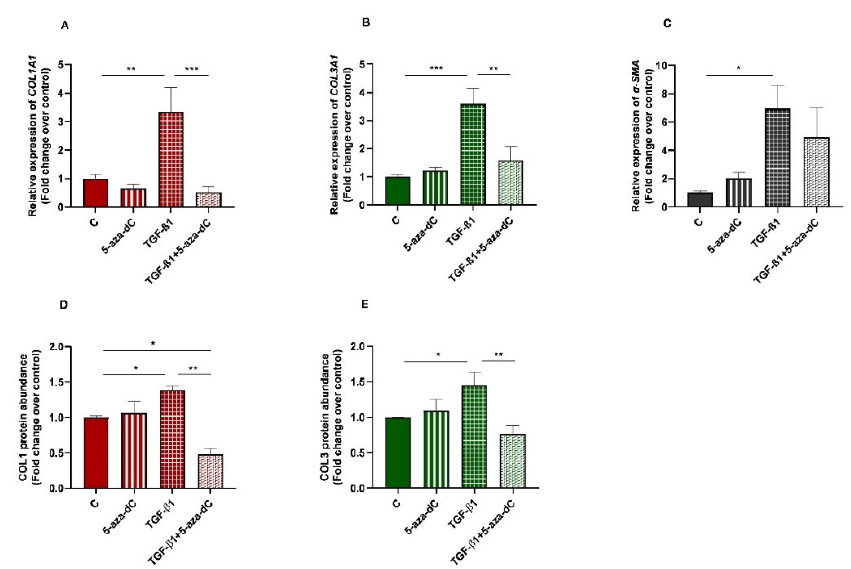
Figure 4. Relative levels of ( A ) collagen type I ( COL1A1 ), ( B ) collagen type III ( COL3A1 ), and ( C ) α‐